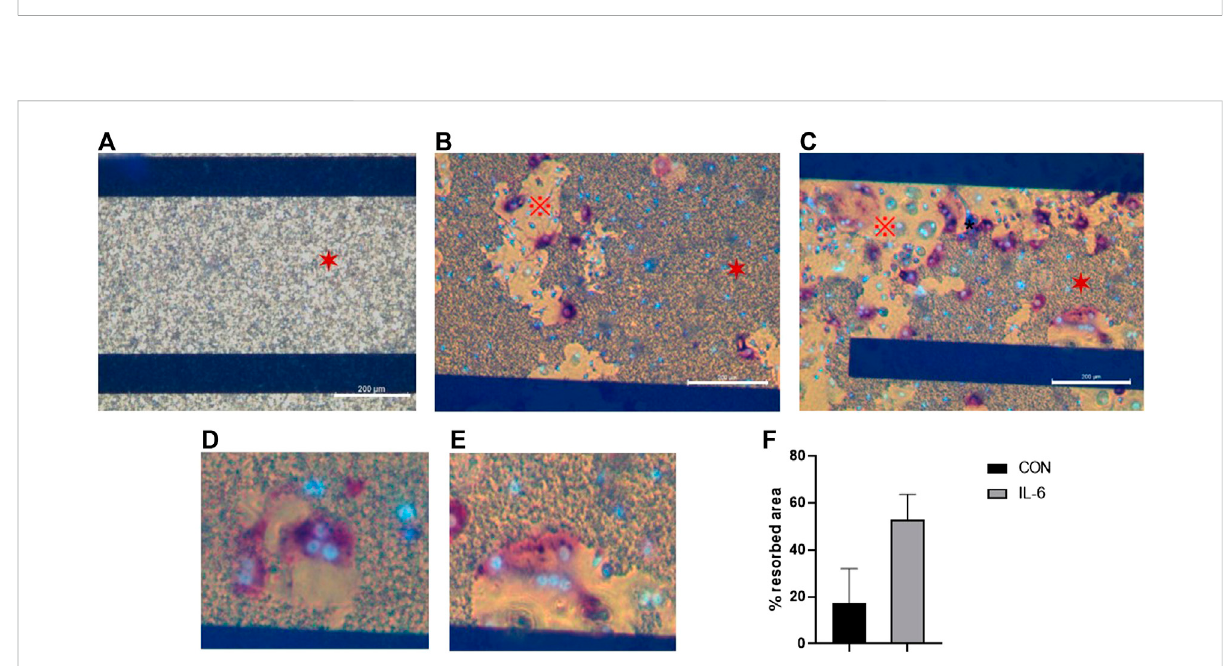
ECIS plate with CAP coating visualized with an inverted microscope. (A) . When no cells were present, the CAP coating ( ✶ ) is completely unaffected. (B) . Cells were cultured for 21 days with M-CSF and RANKL, and osteoclasts from human CD14+-cells were formed and able to dissolve the CAP coating. Osteoclasts were stained for TRAcP (purple) and nuclei with DAPI (blue). (C) . Osteoclasts were activated with IL-6 (i.e., M-CSF + RANKL + IL-6), resulting in higher dissolving activity. Osteoclasts were stained for TRAcP (purple) and nuclei with DAPI (blue). CAP coating ( ✶ ), dissolved area ( ※ ). (D,E) Higher magni fi cation to illustrate that osteoclasts are located at the periphery of the CAP coating, where resorption takes place. (F) PercentageoftheresorbedareaincultureswithM-CSF+RANKL(=CON)andM-CSF+RANKL+IL-6atday21.Bluehorizontalbarsarethe ECIS plate electrodes. Scale bar A-C = 200